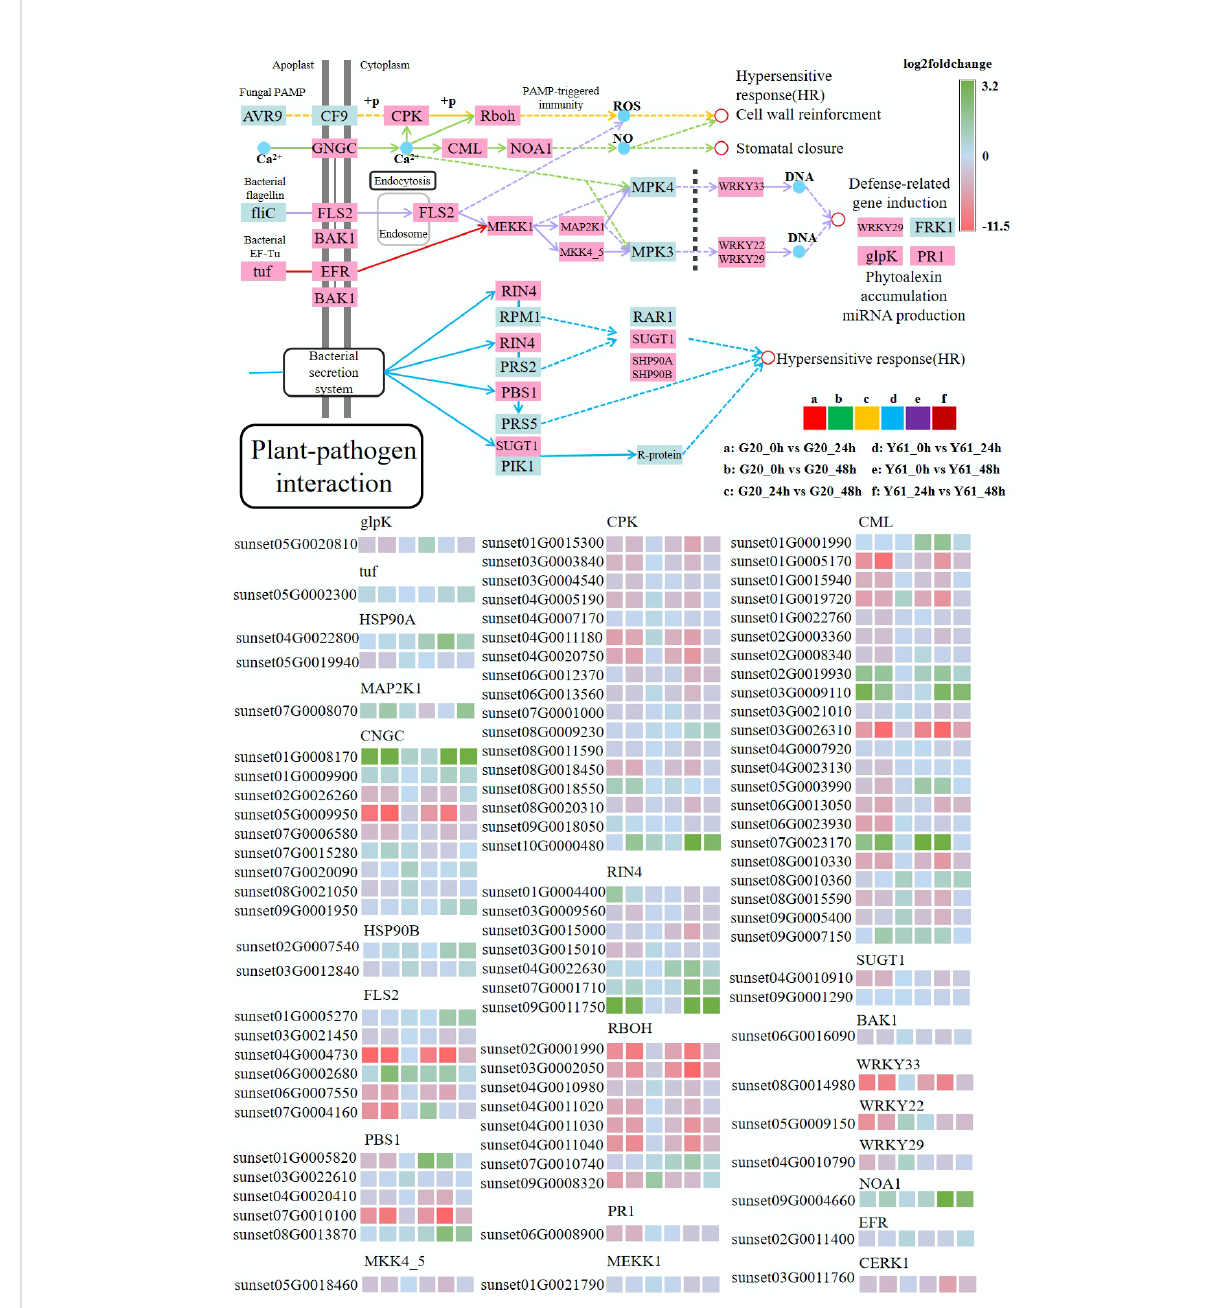
FIGURE 8 Differentially expressed genes in the plant-pathogen interaction pathway. The fold-change is the ratio of the former group to the latter group. The enzymes involved are: glycerol kinase (glpK), elongation factor Tu (tuf), molecular chaperone HtpG (HSP90A), mitogen-activated protein kinase kinase 1 (MAP2K1), cyclic nucleotide-gated channel, plant (CNGC), heat shock protein 90 kDa beta (HSP90B), suppressor of G2 allele of SKP1 (SUGT1), calcium-dependent protein kinase (CPK), mitogen-activated protein kinase kinase 4/5 (MKK4_5), mitogen-activated protein kinase kinase kinase 1 (MEKK1), brassinosteroid insensitive 1-associated receptor kinase 1 (BAK1), LRR receptor-like serine/threonine-protein kinase (FLS2), WRKY transcription factor 33 (WRKY33), WRKY transcription factor 22 (WRKY22), WRKY transcription factor 29 (WRKY29), nitric- oxide synthase, plant (NOA1), LRR receptor-like serine/threonine-protein kinase (EFR), serine/threonine-protein kinase (PBS1), respiratory burst oxidase (RBOH), calcium-binding protein (CML), pathogenesis-related protein 1 (PR1), and RPM1-interacting protein 4